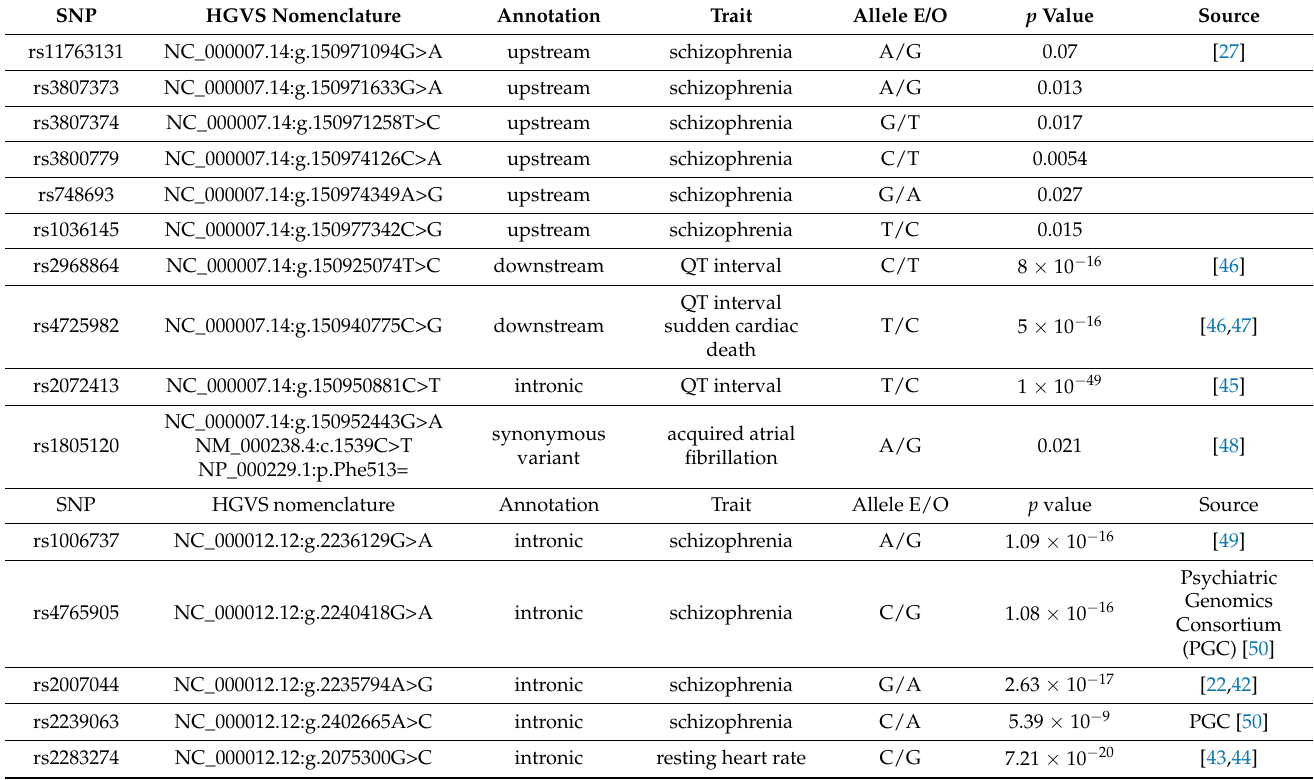
Table 1. Tagging SNPs in the two candidate genes CACNA1C and KCNH2 that have been previously reported to be associated with CADF traits, long QT syndrome, and/or